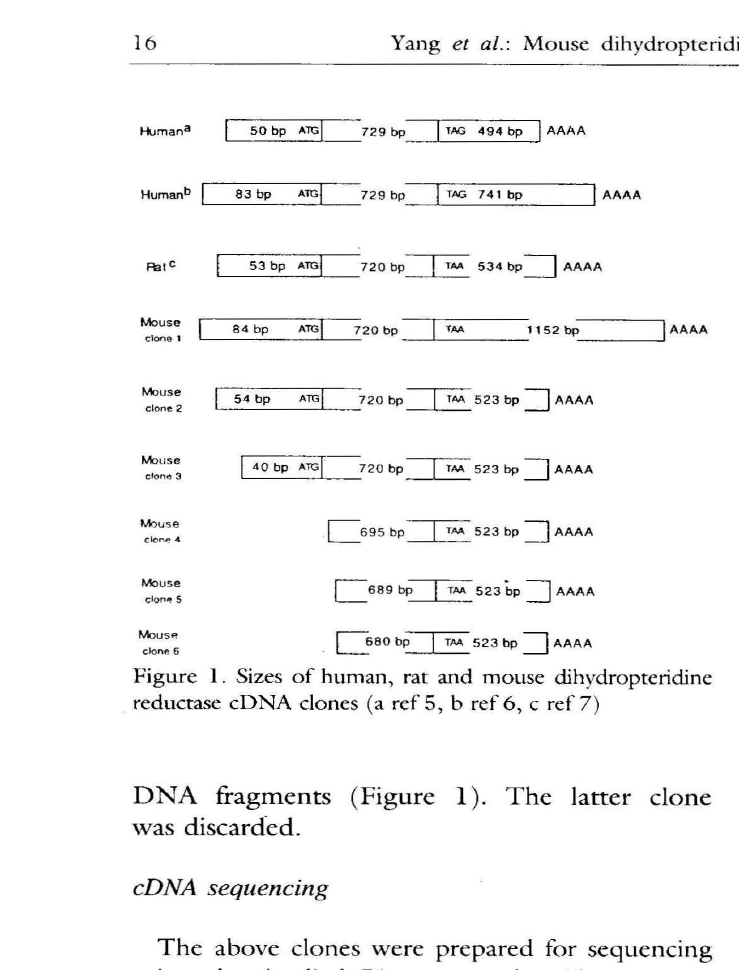
DNA fragments (Figure 1). The latter clone was